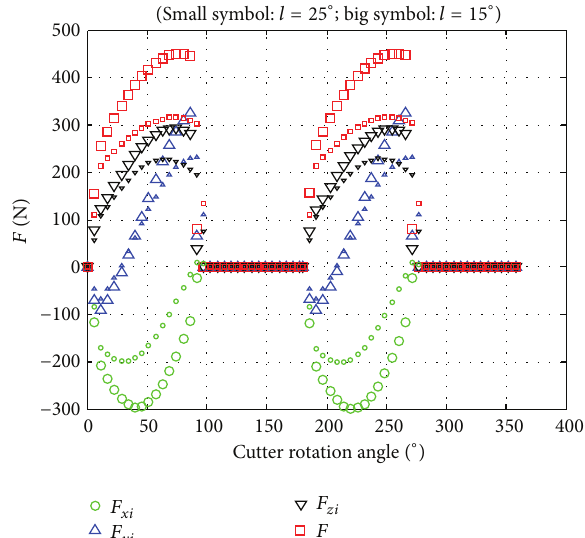
Figure 11: Effect of tilt angle on cutting force.